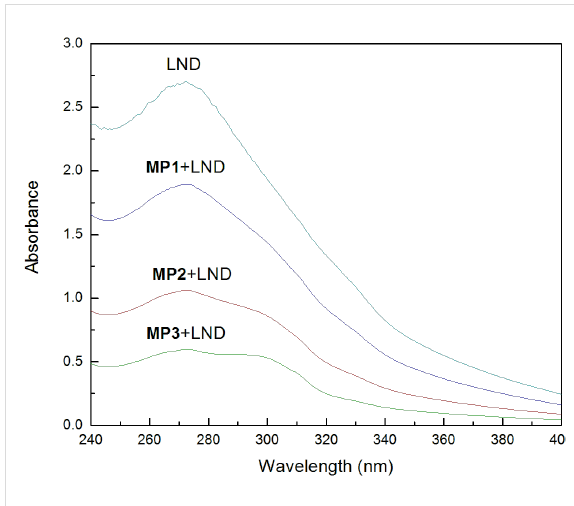
Figure 3: UV–vis spectra of LND solutions in the presence of MP1, MP2 and MP3 in buffer solutions.